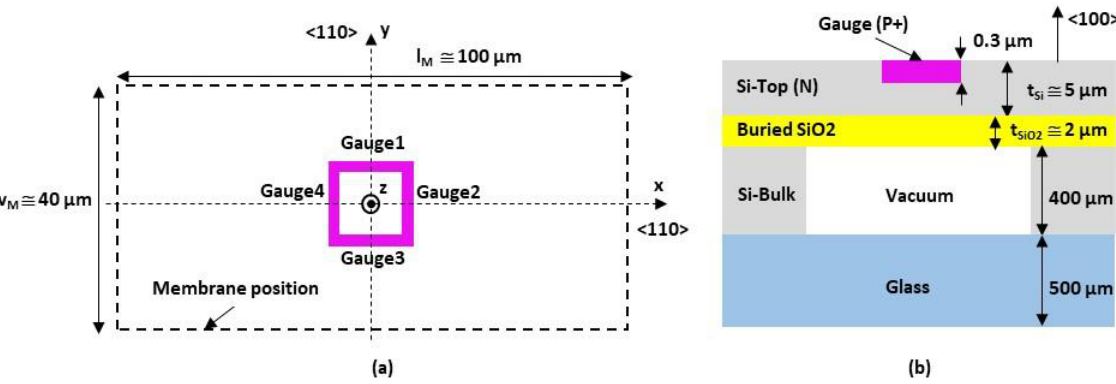
Figure 10. ( a ) Top view of the Wheatstone bridge reported at the center of the membrane surface; ( b ) cross-sectional view of the transducer.